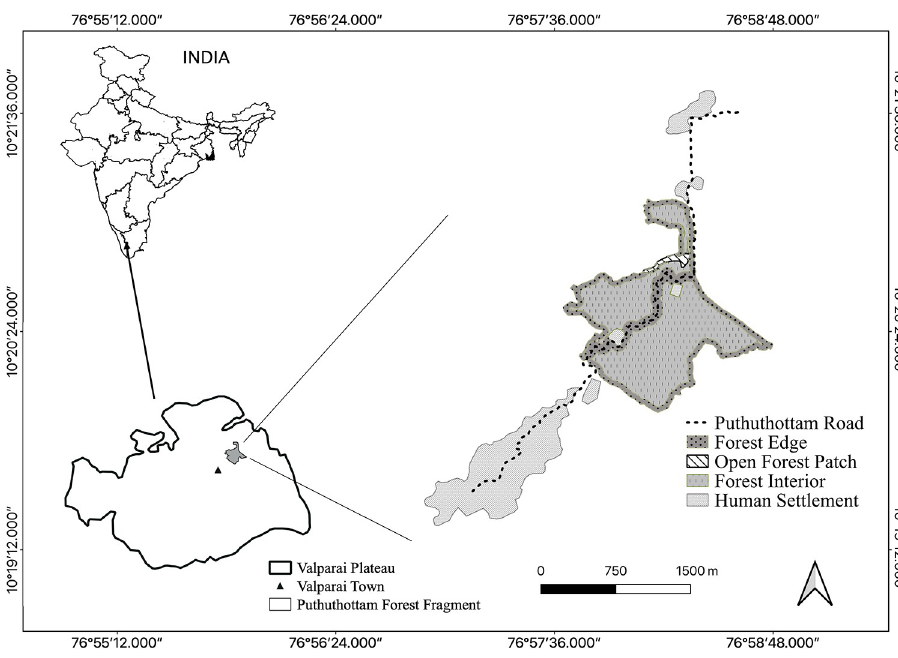
Fig 1. The study habitat types within the Puthuthottam forest fragment, located on the Valparai plateau in the Anamalai Hills, southern India.